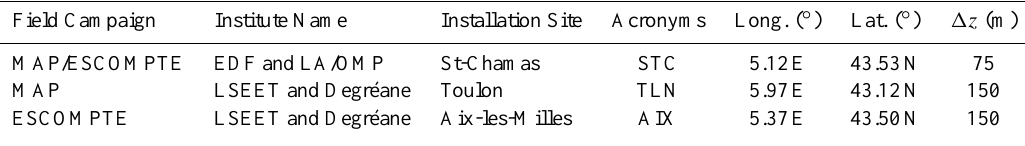
Table 2. Summarized information on the UHF wind profilers used in the present